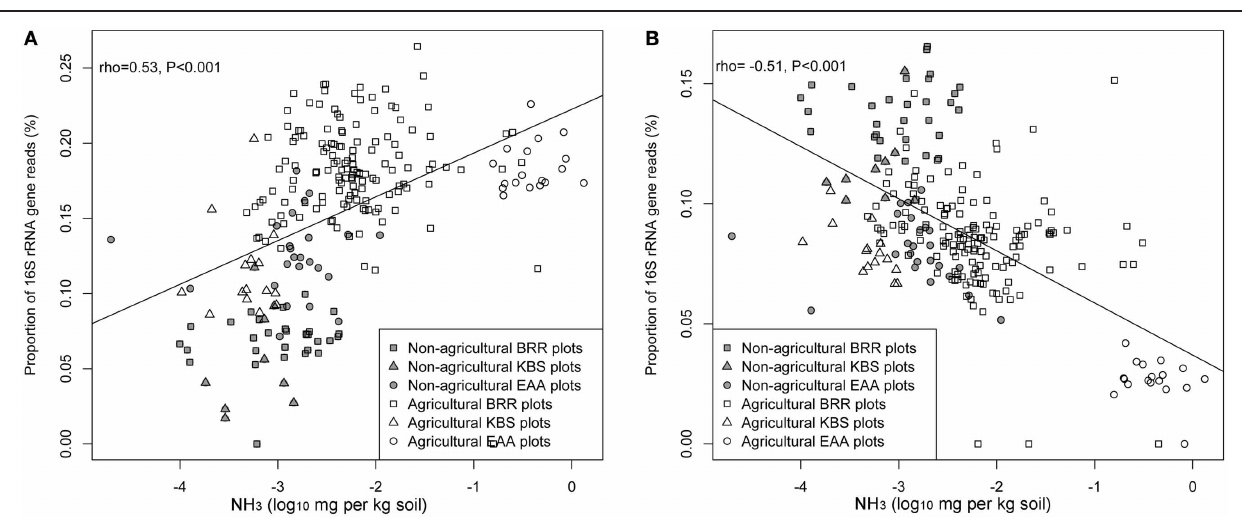
Agricultural and non-agricultural plots were analyzed together (n = 158). *Significant, p-value ≤ 0.001.